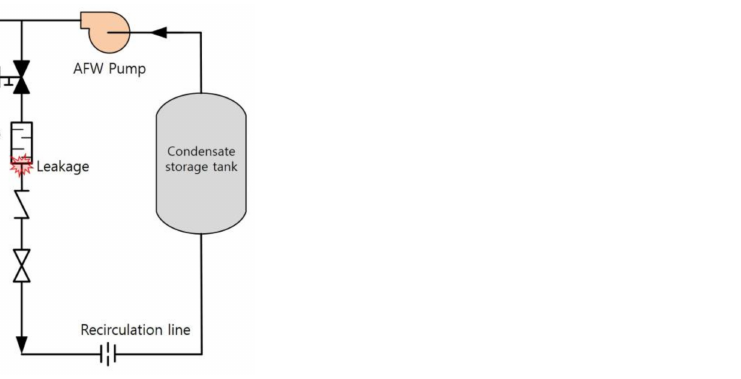
Figure 1. Schematic diagram for the auxiliary feedwater (AFW) pump recirculation line of the domestic nuclear power plant (NPP).